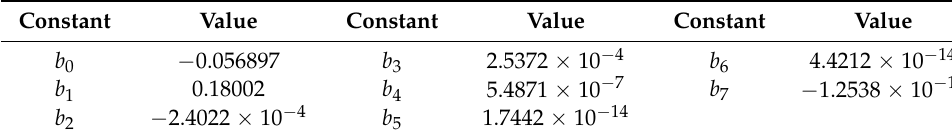
. m compound = f ( N , p ) .